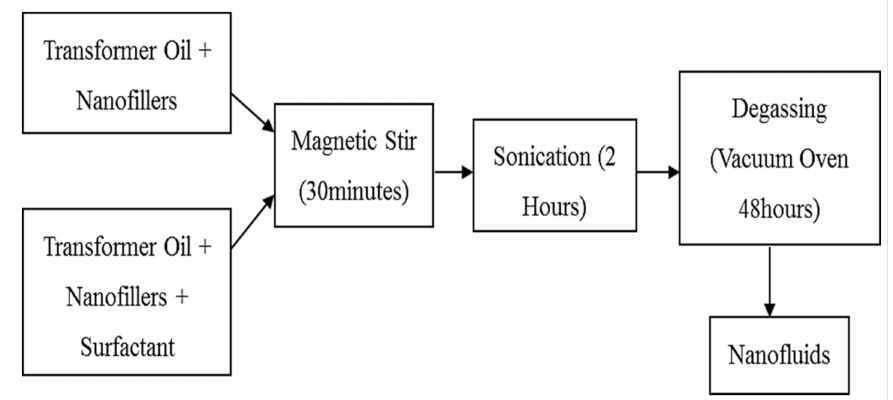
Figure 2. Flowchart for the preparation of mineral oil-based alumina